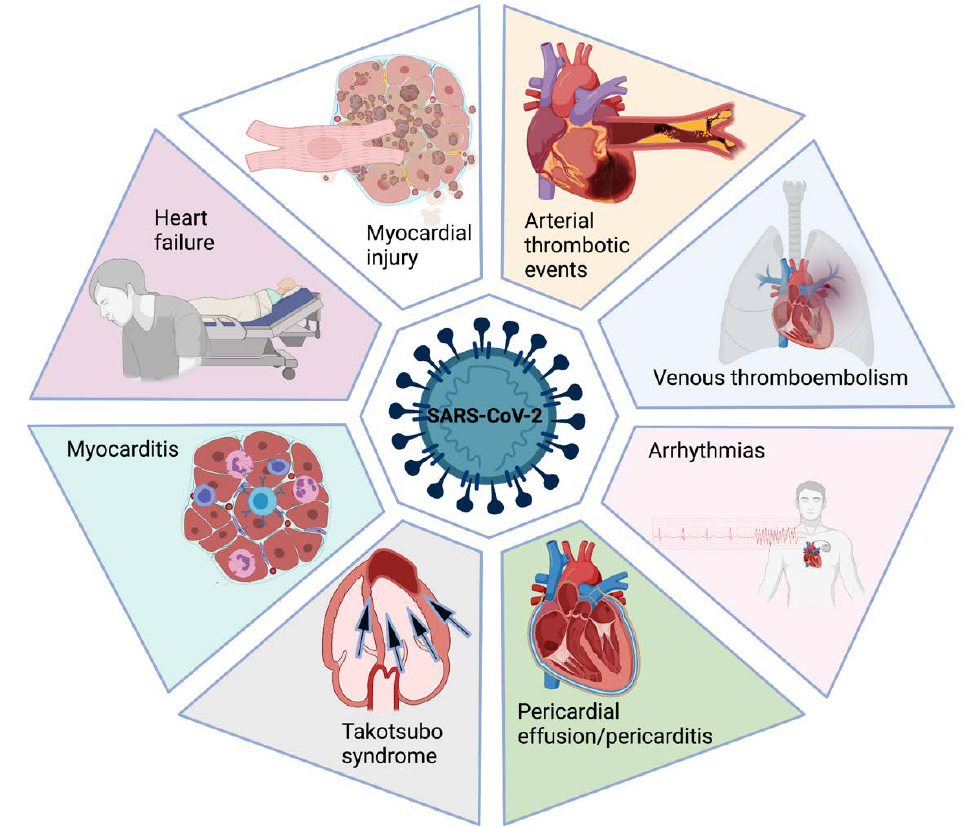
Figure 1. COVID-19 cardiovascular manifestations. Cardiovascular involvement due to COVID-19 ranges from asymptomatic myocardial injury to more severe complications such as type 1 myocardial infarction, arterial or venous thromboembolism, or myocarditis.